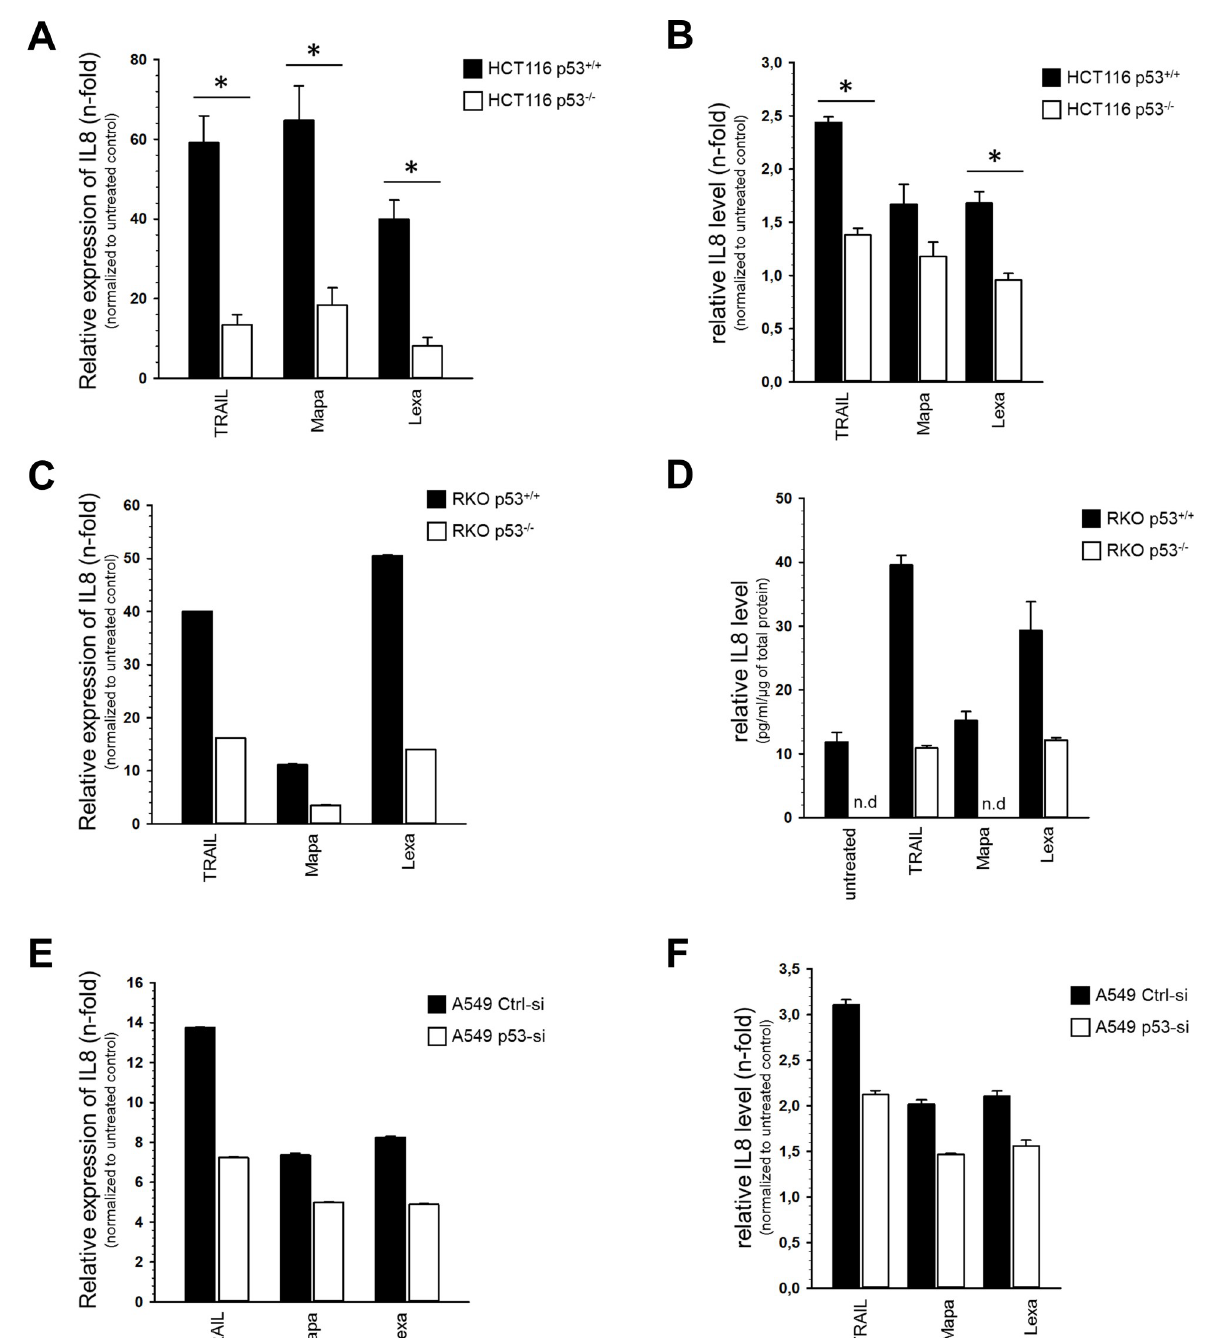
Fig 5. Impact of p53 status on TRAIL-R-mediated IL8 induction. HCT116 cells, RKO cells and A549 cells were stimulated either with TRAIL (100 ng/ml), Mapatumumab (10 μ g/ml) or Lexatumumab (10 μ g/ml) for 3 h. Relative expression of IL-8 mRNA level (normalized to TBP) was analyzed by qPCR (A, C, E). Relative expression of IL-8 protein level was analyzed by ELISA (B, D, F). Thee independent experiments, each performed in triplicates ± SD (n = 3) are shown in (A, B, D). One representative experiment out of three performed, each performed in triplicates ± SD are shown in (C, E,